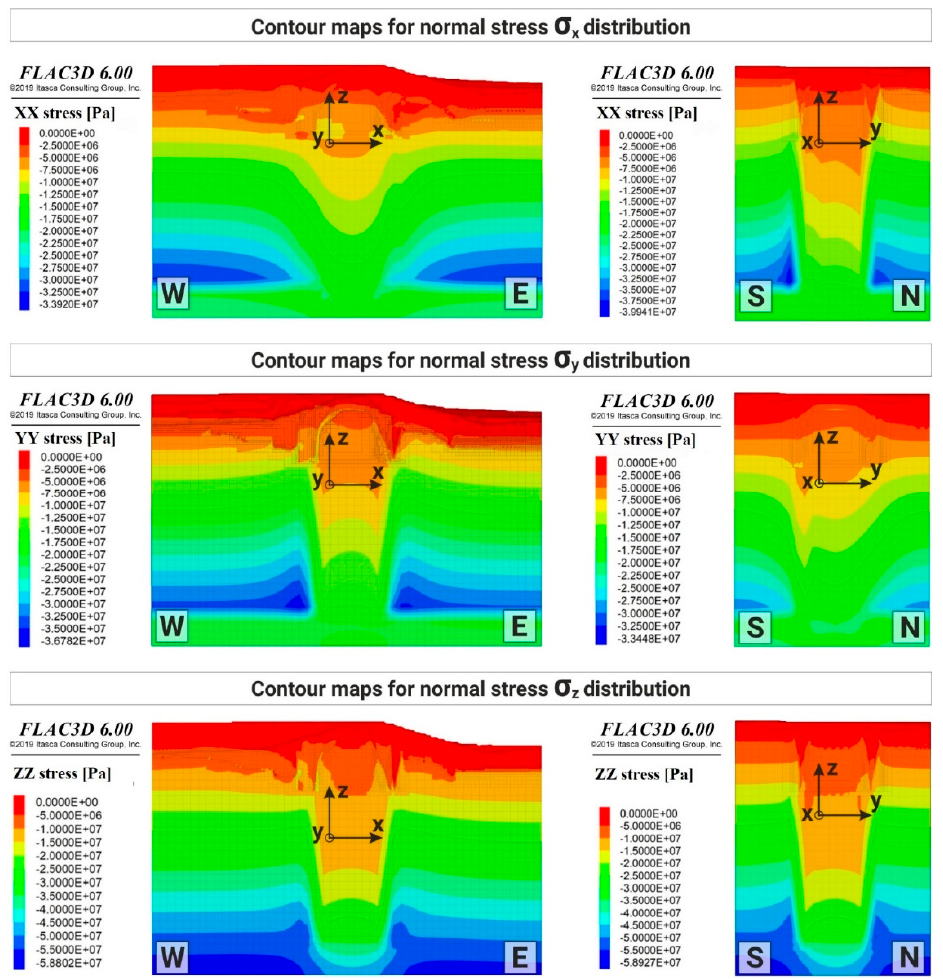
Figure 12. The horizontal and vertical stress distribution in the DSD and the surrounding area in October 2018. October